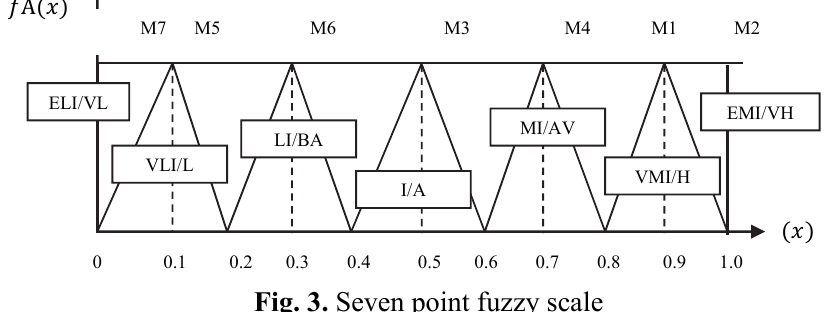
Fig. 3. Seven point fuzzy scale